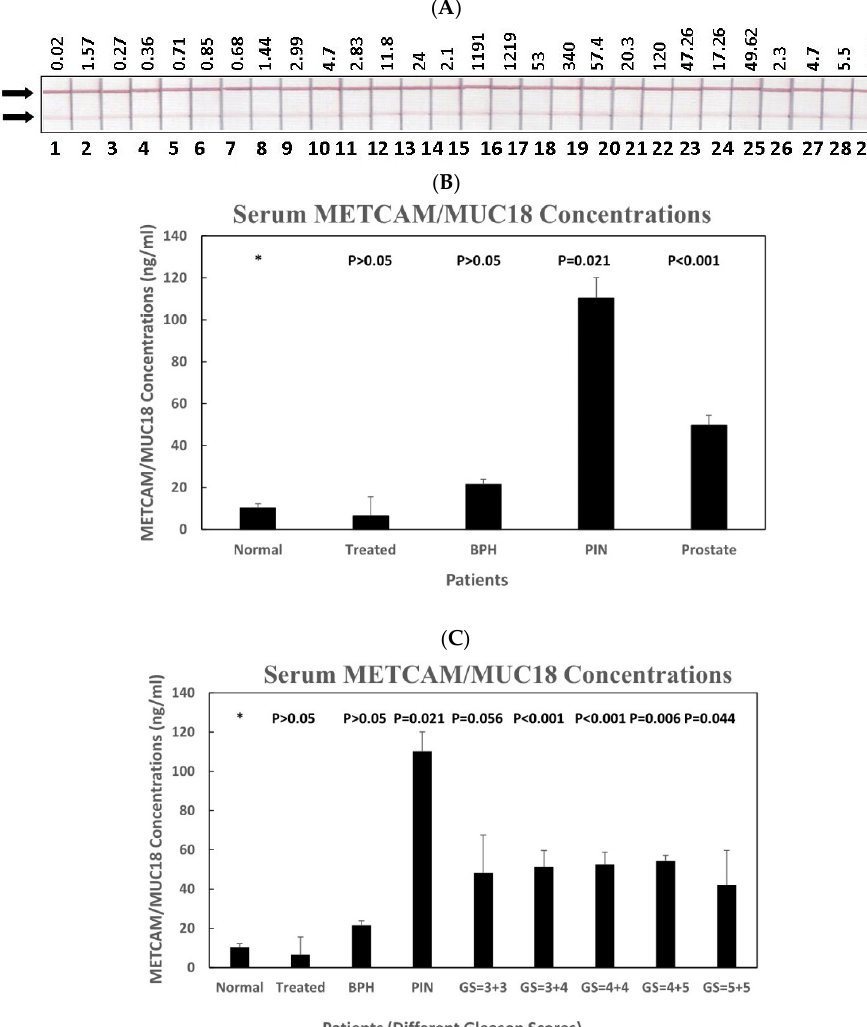
Figure 6. ( A ) Serum image for Combo2, ( B ) METCAM in patients Combo2, ( C ) METCAM in patients with Gleason score combo2. HuMETCAM/MUC18 concentrations in various human serum samples were determined by a modified LFIA method using the combination of biotinylated chicken antibody and nanogold-conjugated rabbit antibody (EPP11278) and its relation to the status of patients. ( A ) shows the intensities of various human serum samples on the test lines (T). ( B ) shows the average METCAM/MUC18 concentrations with standard deviations in the serum samples from the treated prostate cancer patients, prostate cancer patients, patients with prostate premalignant PIN, or BPH, were compared to those from normal individuals. The number on top of each bar was the p value when the data were compared to the normal after statistical analysis, as described in “Materials and Methods.” ( C ) shows the average METCAM/MUC18 concentrations with standard deviations in the serum samples from the treated prostate cancer patients, prostate cancer patients with different Gleason score, and patients with prostate premalignant PIN, or BPH, compared to those from normal individuals. The number on top of each bar was the p value when the data were compared to the normal after statistical analysis, as described in “Materials and Methods”.